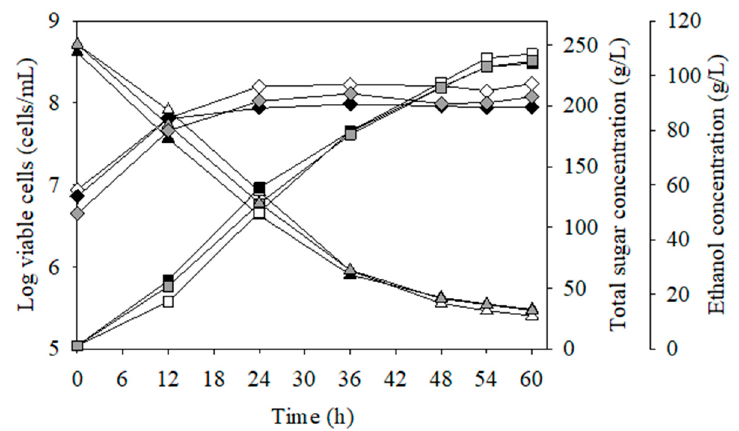
Figure 4. Profiles of batch ethanol fermentation in CR by immobilized cells on rattan pieces at various carrier loadings: 30% (white symbols), 50% (gray symbols), and 70% (black symbols) of dried rattan pieces ( , , = viable cells; , , = total sugar and , , = ethanol concentration ) . Table 1. Batch ethanol fermentation efficiency in a CR by immobilized cells at different rattan loadings. of Rattan (%)